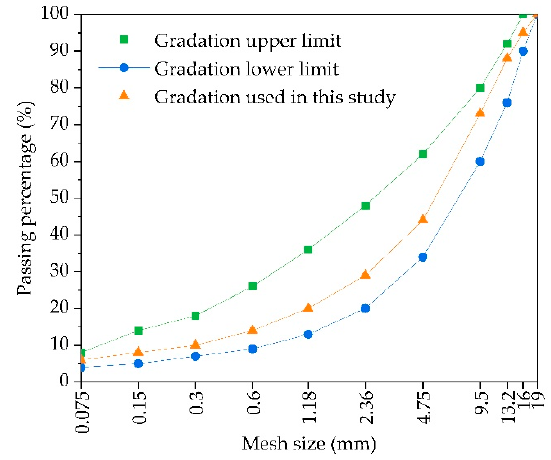
Figure 1. The mineral aggregate gradation curve of AC-16.